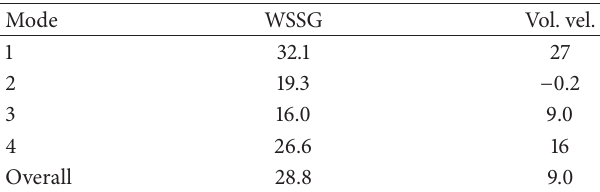
Table 5: Overall sound attenuation in each of the four radiation modes targeted by WSSG, as shown in Figures 6–11.